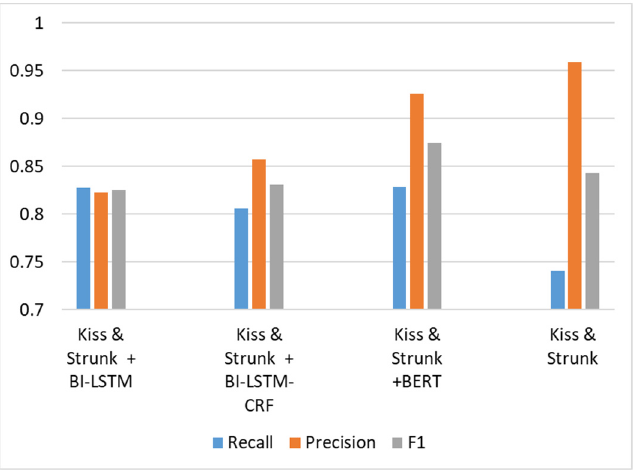
Figure 13. Comment boundary detection results using different models.